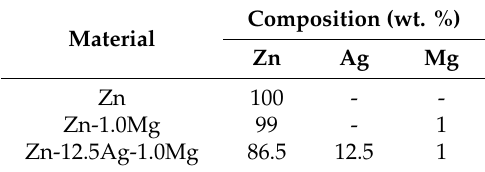
Table 1. Nominal compositions (weight %) of the investigated alloys. Material